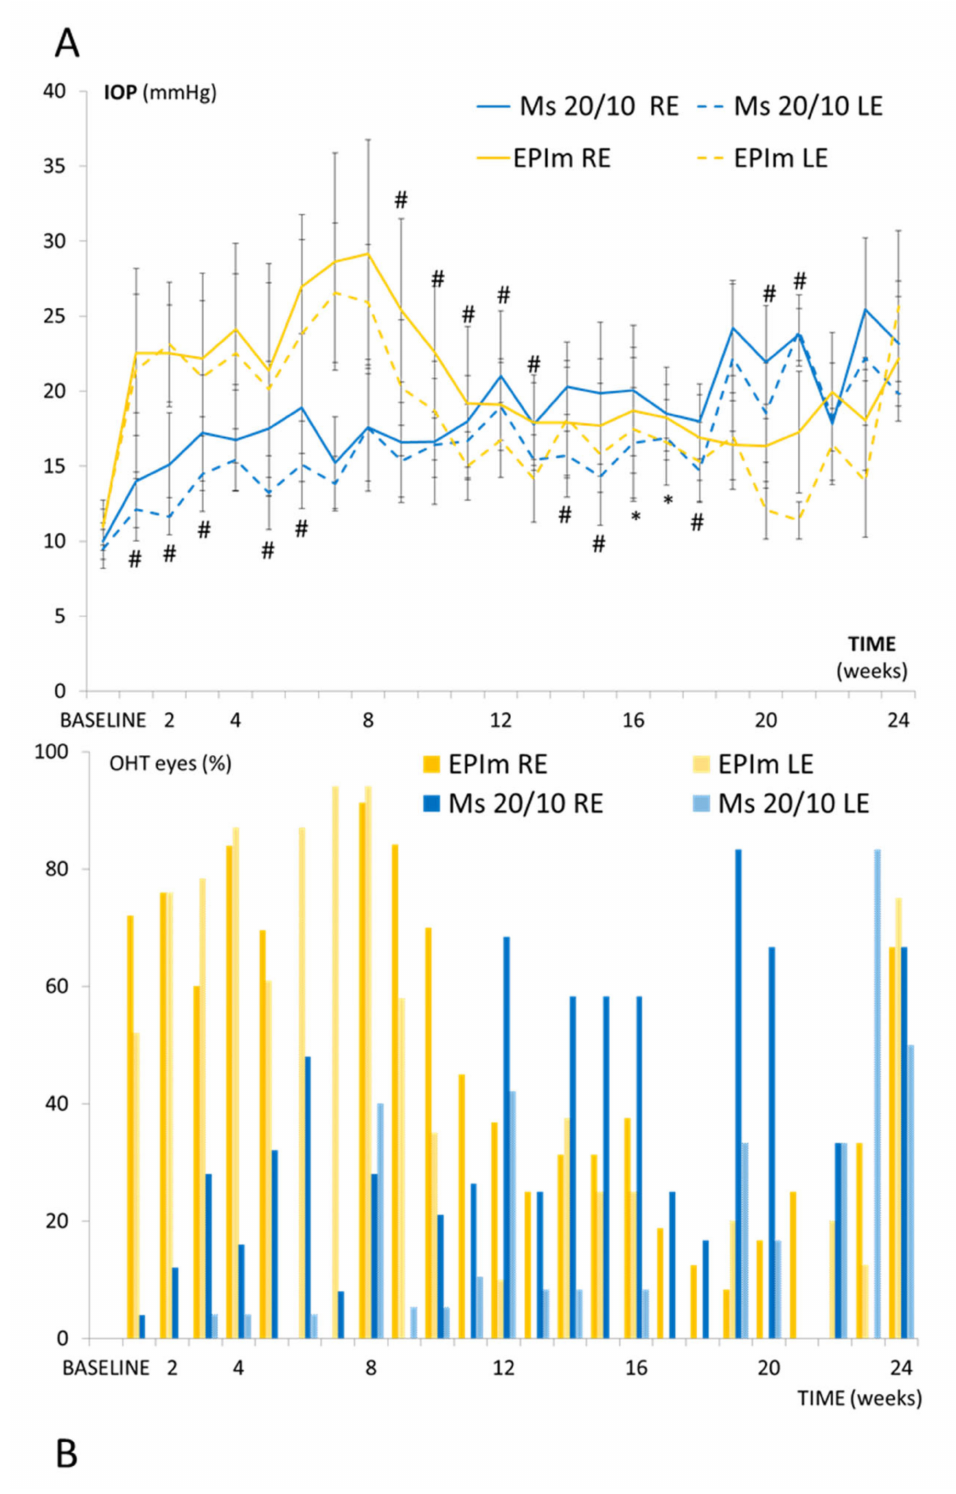
Figure 3. ( A ): Intraocular pressure comparison over 6 months in both ocular hypertensive